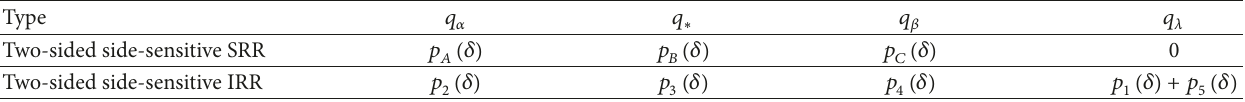
Table 10: The elements of the TPM of the two-sided side-sensitive SRR and IRR w-of-w monitoring schemes. Type 𝑞 𝛼 𝑞 ∗ 𝑞 𝛽 𝑞 𝜆 Two-sided side-sensitive SRR 𝑝 𝐴 (𝛿) 𝑝 𝐵 (𝛿) 𝑝 𝐶 (𝛿) 0 Two-sided side-sensitive IRR 𝑝 2 (𝛿) 𝑝 3 (𝛿) 𝑝 4